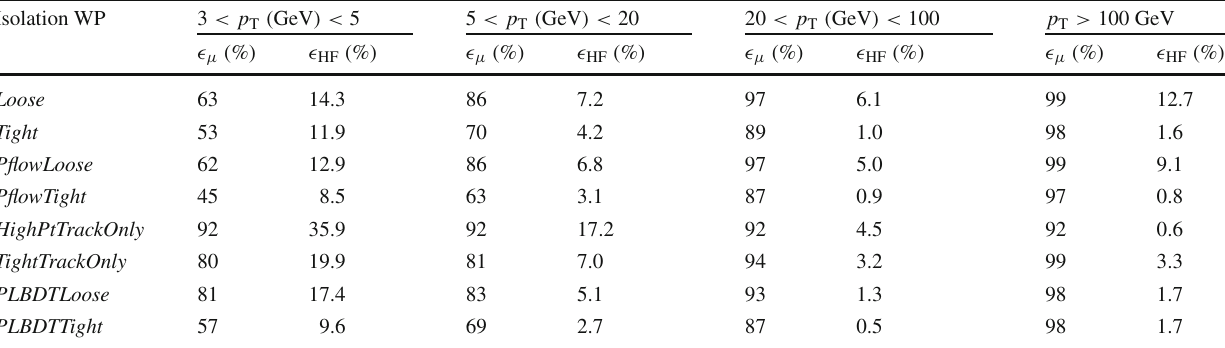
Table 3 Isolation efficiencies for prompt muons, (cid:14) μ , and muons from bottom and charm semileptonic decays, (cid:14) HF , for the different isolation working points, evaluated in a t ¯ t MC sample in different p T regions for tracks satisfying the Medium identification and the vertex associ-